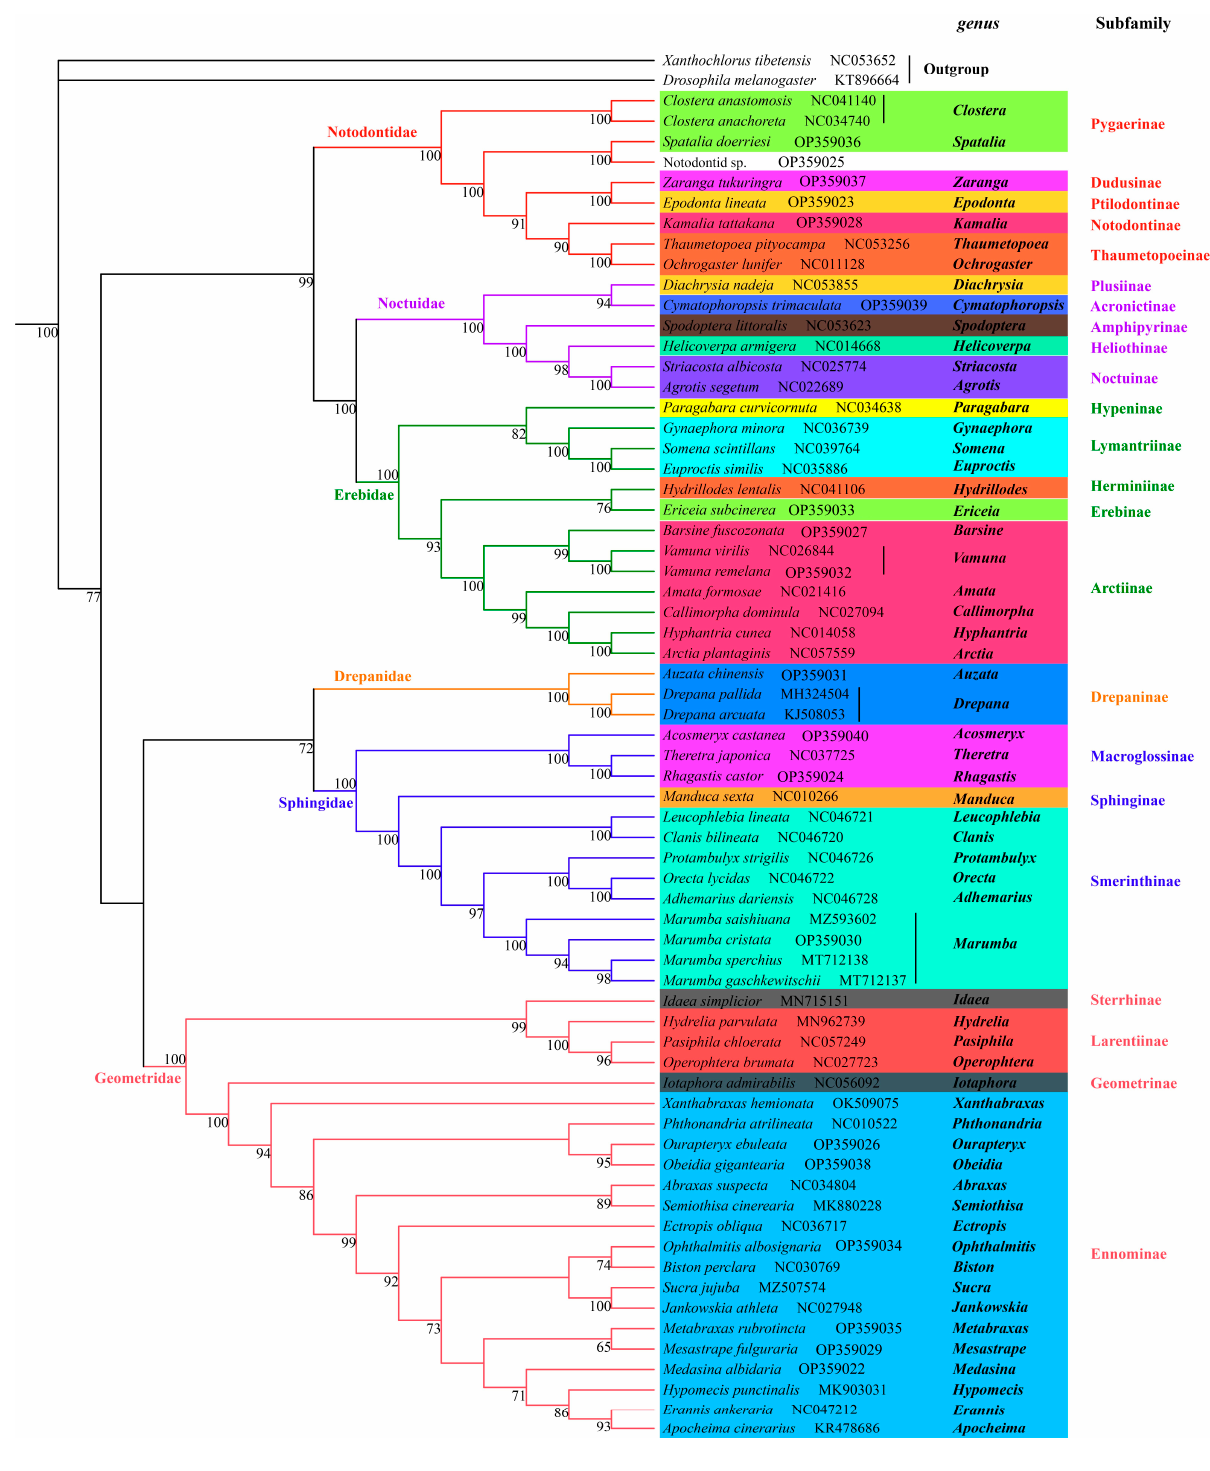
Figure 6. Phylogenetic tree inferred from nucleotide sequences of 13 PCGs using the ML analysis. Numbers on the branches are ML bootstrap support.